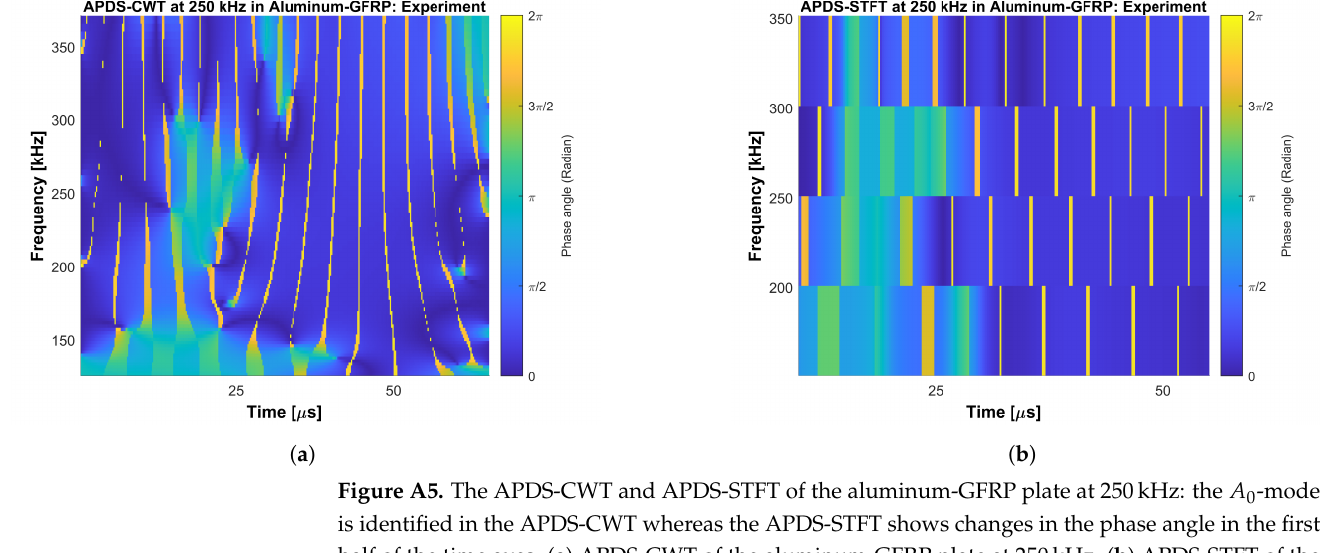
Figure A5. The APDS-CWT and APDS-STFT of the aluminum-GFRP plate at 250kHz: the A 0 -mode is identified in the APDS-CWT whereas the APDS-STFT shows changes in the phase angle in the first half of the time axes. ( a ) APDS-CWT of the aluminum-GFRP plate at 250kHz. ( b ) APDS-STFT of the aluminum-GFRP plate at